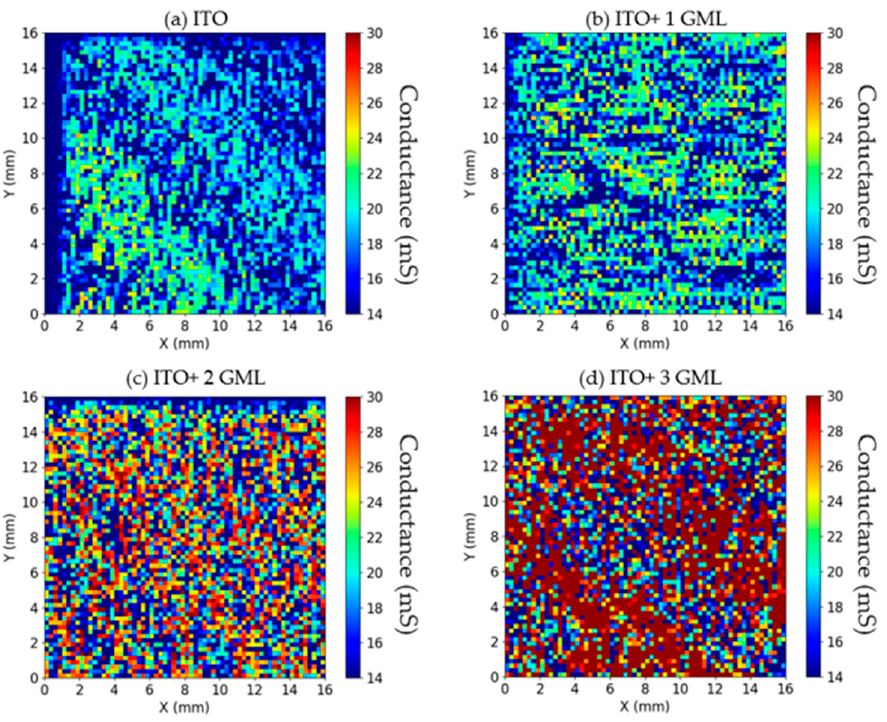
Figure 4. Reflection-mode terahertz time-domain spectroscopy results obtained in the cells